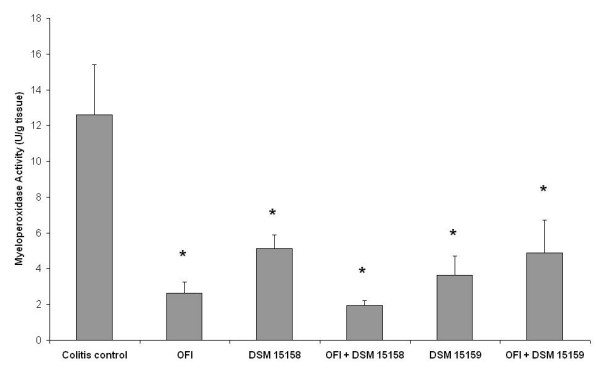
Colonic Myeloperoxidase Activities (U/g tissue). * denotes p < 0.05 compared to colitis control.